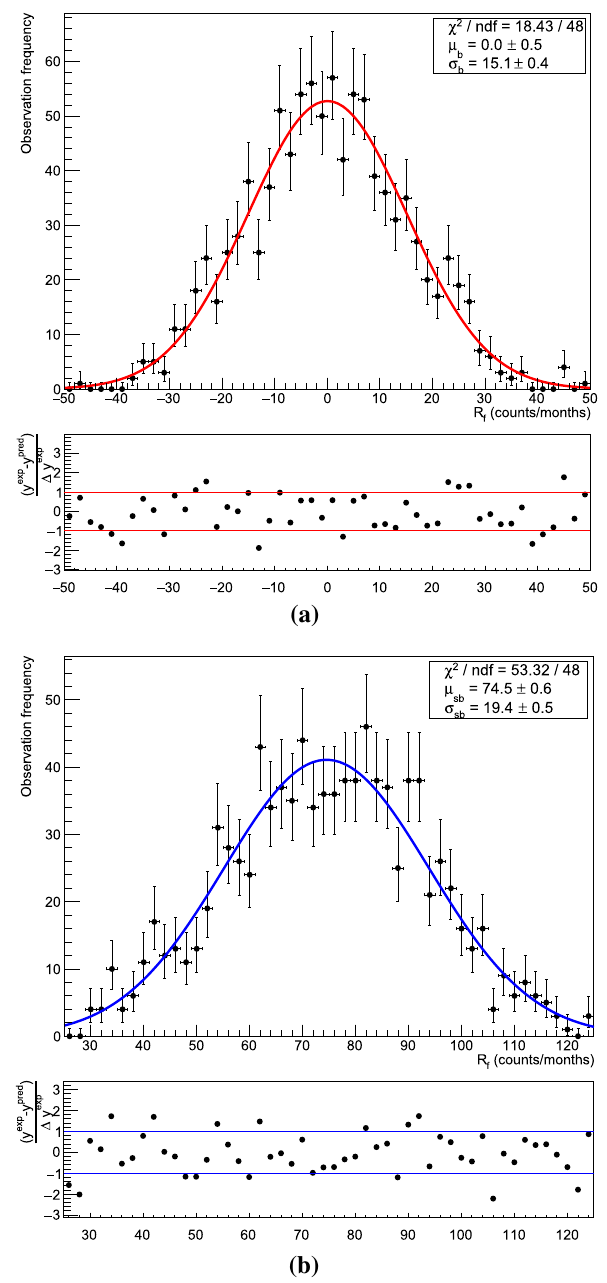
Fig. 3 Background only (top) and signal+background (bottom) dis- tributions, for R b = 1 cpd/kg/keV over 3 years, and signal given by DAMA. These are plotted as a function of the number of modulation events observed per month